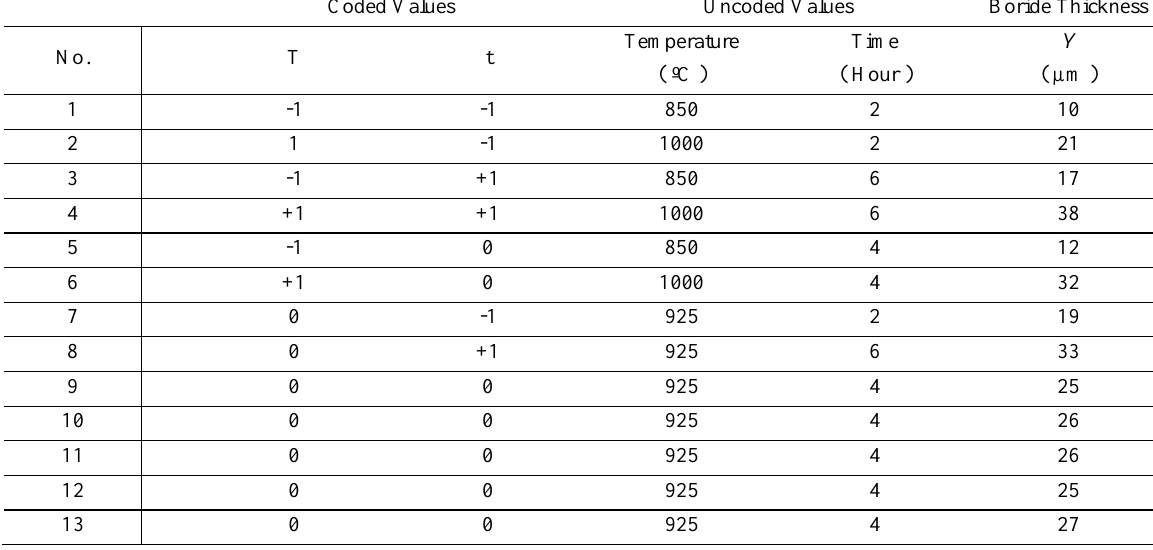
Table 2. Face centered composite design of two factors for coded, uncoded and response ( boride layer thickness